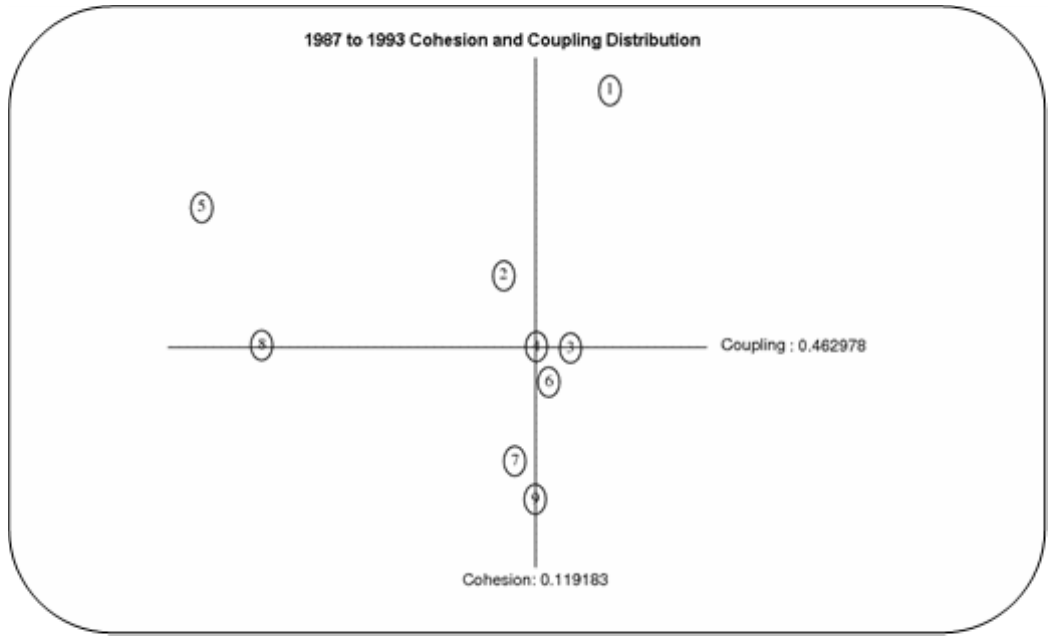
Figure 6. The lexical maps